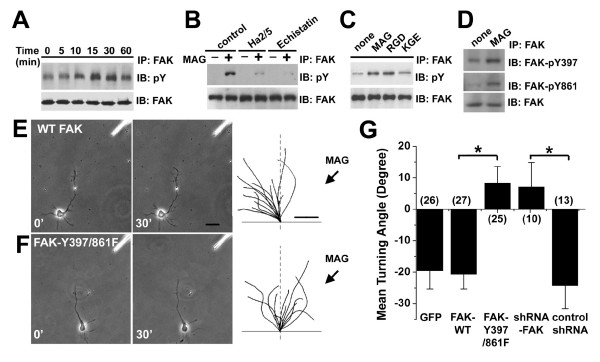
MAG-induced tyrosine phosphorylation of FAK is required for growth cone repulsion to MAG. A-C. MAG induces phosphorylation of FAK. Shown in (A) is the time course of FAK phosphorylation after MAG stimulation (2 μg/ml) of rat hippocampal neurons. Cell lysates were immunoprecipitated with anti-FAK antibodies and immunoblotted with the pY-20 antibody for phosphorylated tyrosine residues. Shown in (B) are experiments in the presence or absence of Ha2/5 (1.0 μg/ml) or echistatin (100 nM). Shown in (C) are experiments with the treatment of WT-MAG (RGD) or mutant MAG (KGE). D. MAG induces phosphorylation of FAK on residues Y397 and Y861. Cell lysates of hippocampal neurons after MAG stimulation were immunoprecipitated with anti-FAK antibodies and immunoblotted with tyrosine phosphorylation site-specific antibodies to FAK. E-G, Phosphorylation of FAK on residues Y397 and Y861 is required for MAG-induced growth cone repulsion. Hippocampal neurons were transfected with expression constructs for GFP, WT-FAK-GFP (E), FAK-Y397/861F-GFP (F), GFP and control shRNA, GFP and shRNAs against FAK. Growth cones of GFP+ neurons were examined in a gradient of MAG (150 μg/ml in the pipette). Sample images and traces were shown similarly as in Fig. 2 (A-C). Scale bar: 20 μm for microscopic images and 5 μm for traces. Shown in (G) is the summary of growth cone turning angles. Values represent mean ± s.e.m. Numbers associated with the bar graph indicate the number of growth cones analyzed. "*" indicates significant difference from the control (neurons transfected to express GFP alone; p < 0.01, ANOVA).